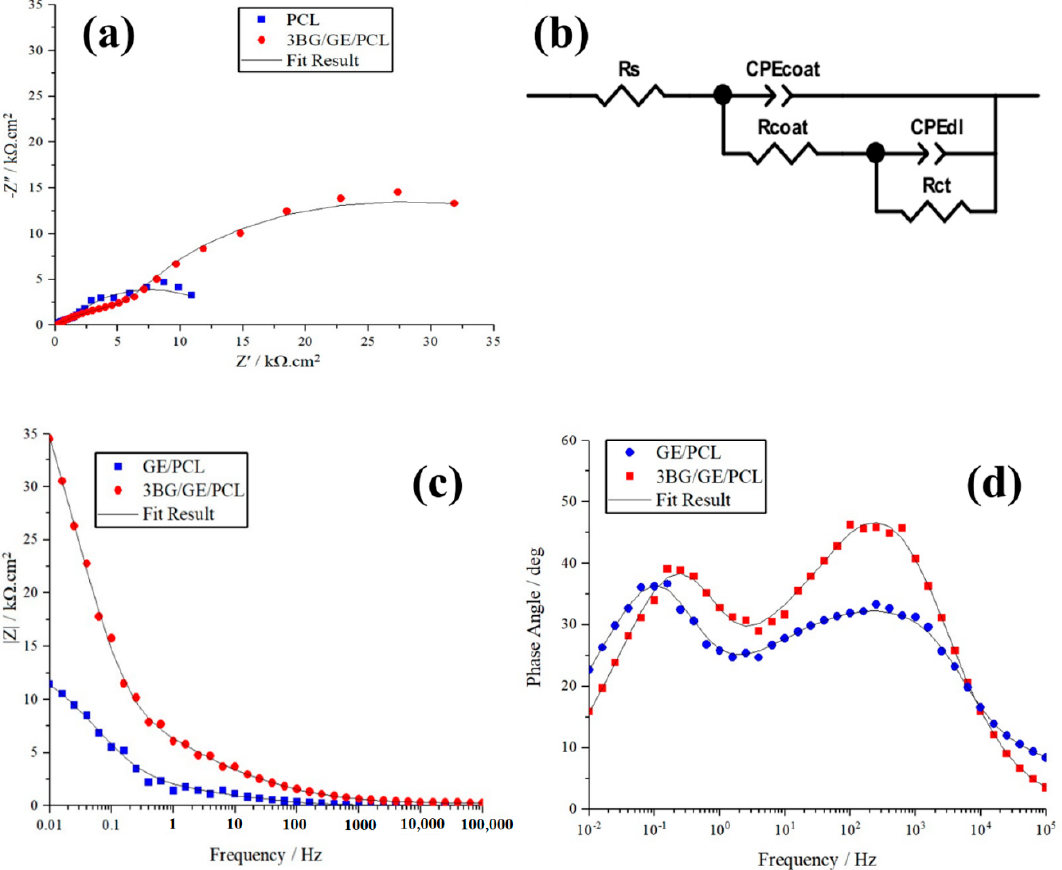
Figure 5. ( a ) Nyquist plots, ( b ) the equivalent circuit used to simulate the electrochemical impedance spectroscopy (EIS) experimental data, ( c ) the Bode-Z and ( d ) Bode-phase diagrams of 3BG / GE / PCL and GE / PCL in a PBS solution at room temperature.